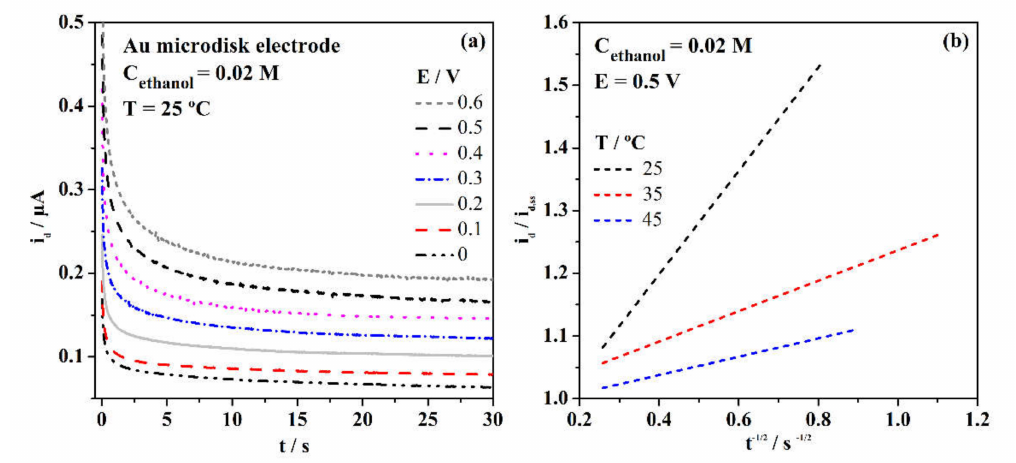
Figure 6. ( a ) Current transients following application of potentials in the 0–0.6 V range in 0.02 M ethanol + 2 M NaOH solution at 25 ◦ C and ( b ) i d / i d,ss vs. t − 1 / 2 plots for an applied potential of 0.5 V at 25, 35, and 45 ◦